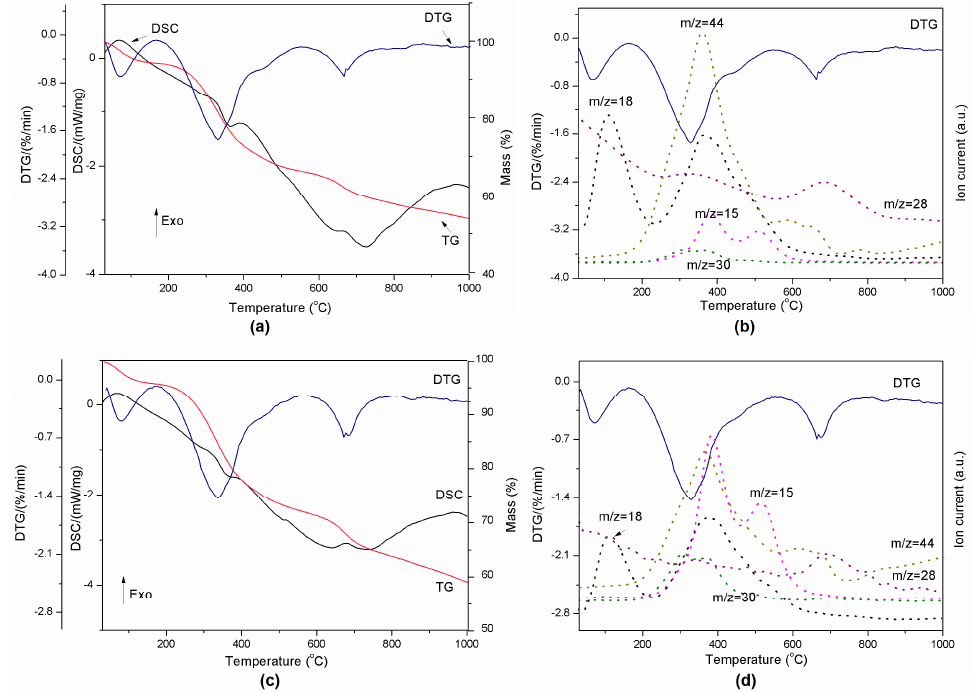
Figure 5. Thermal decomposition of lignin-Al 2 O 3 (8:2, wt / wt ) represented by DSC-TG-DTG ( a ) and DTG-MS curves ( b ) and lignin-Al 2 O 3 (8:4, wt / wt ) represented by DSC-TG-DTG ( c ) and DTG-MS curves ( d ).